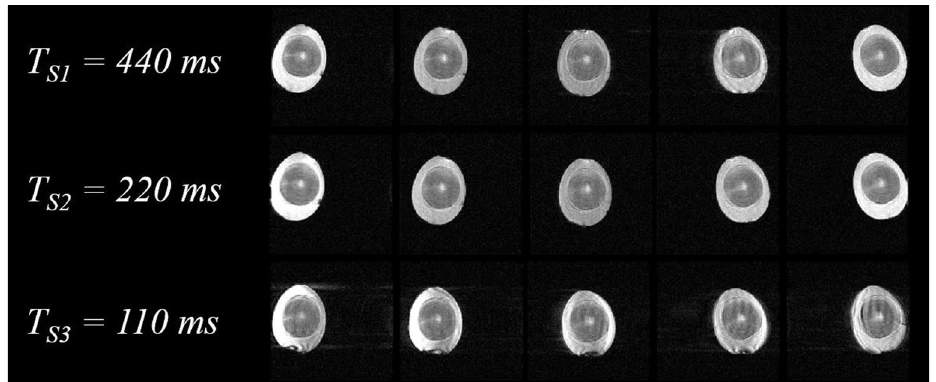
Figure 7. Images of cooked egg with different rotational motion speeds in their relative positions. The sinusoidal periods ( T S ) of voltage input to the actuator (and thus the swing motion period) were 440 ms, 220 ms, and 110 ms for T S 1 , T S 2 , and T S 3 , respectively. Increased level of image artifact is observed for the fastest motion at T S 3